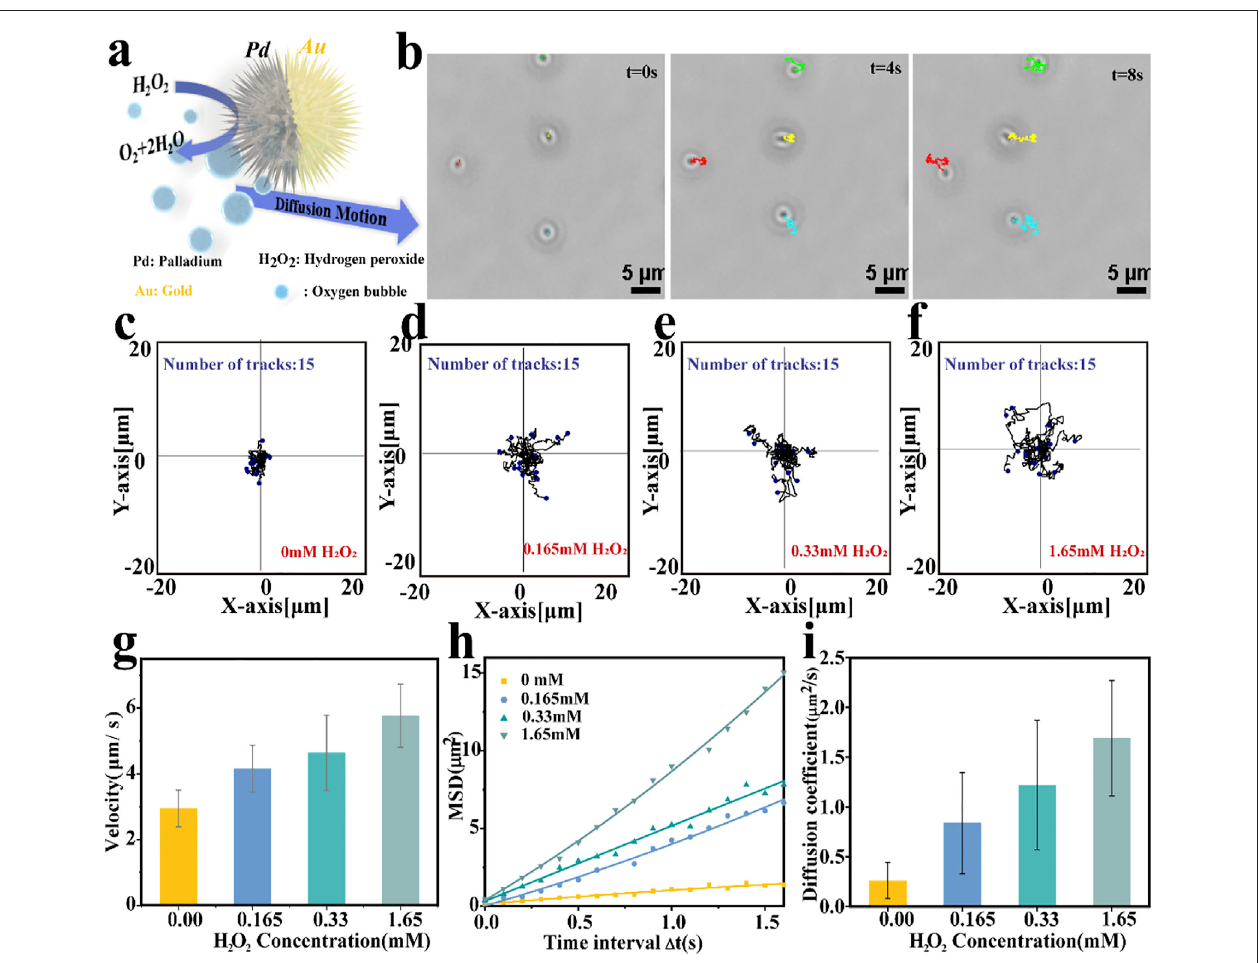
FIGURE3|(A) SchematicdiagramofthepropulsionmechanismofspikyPd/Aubimetallicnanomotorswhichdependonthedecompositionofhydrogenperoxide. (B) Time-lapse images showing the movement of Pd/Au nanomotors in the presence of hydrogen peroxide fuel (0.165 mM H 2 O 2 ) at 0,4,8 s, respectively; The scale bar was 5 μ m. (C – F) Tracking paths (time interval = 100 ms, duration 10 s; 15 trajectories were analyzed) of Pd/Au nanomotor under different H 2 O 2 concentrations (0.00 mM,0.165 mM,0.33 mM,1.65 mM,respectively). (G) AveragevelocityofPd/Aunanomotorsatdifferentfuelconcentrations. (H) Meansquaredisplacements (MSD)curve and (I) corresponding diffusion coef fi cients of Pd/Au nanomotors with different H 2 O 2